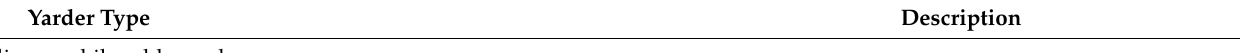
Table 3. Summary of the medium and large mobile cable yarders in Korea 1980–2021.